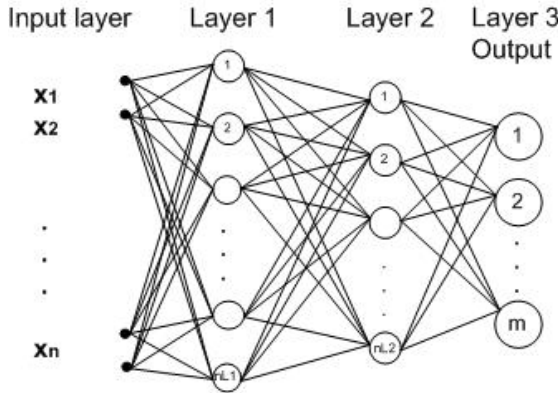
Figure 4. Neural network basic structure using two hidden